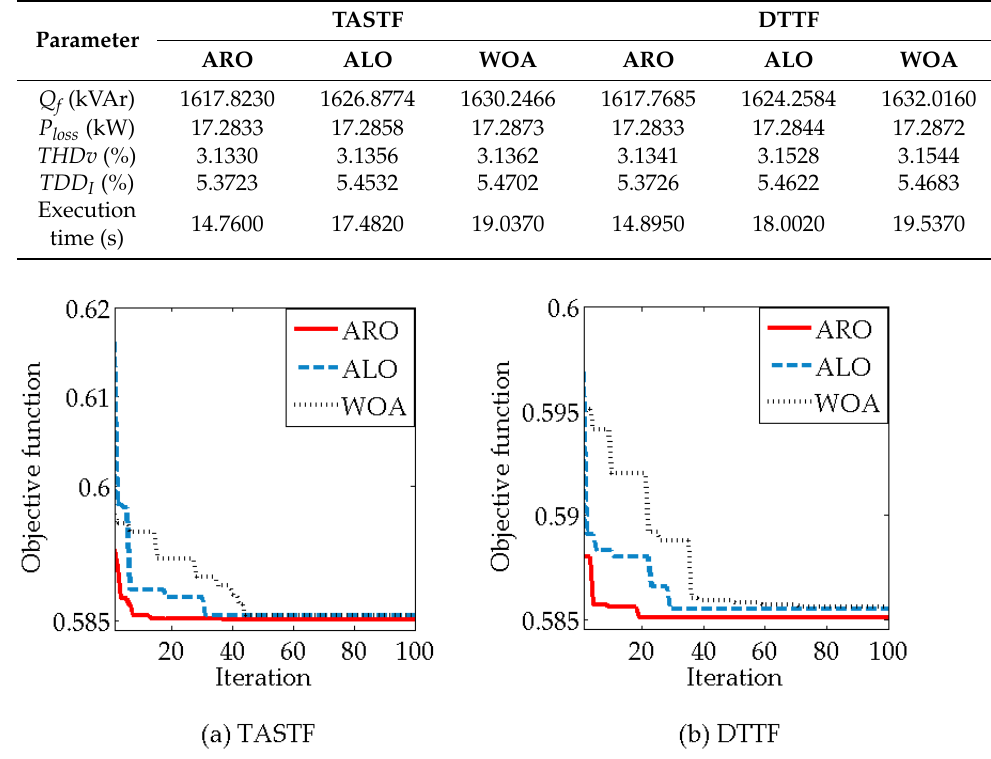
Figure 8. ARO, ALO, and WOA’s convergence curves.